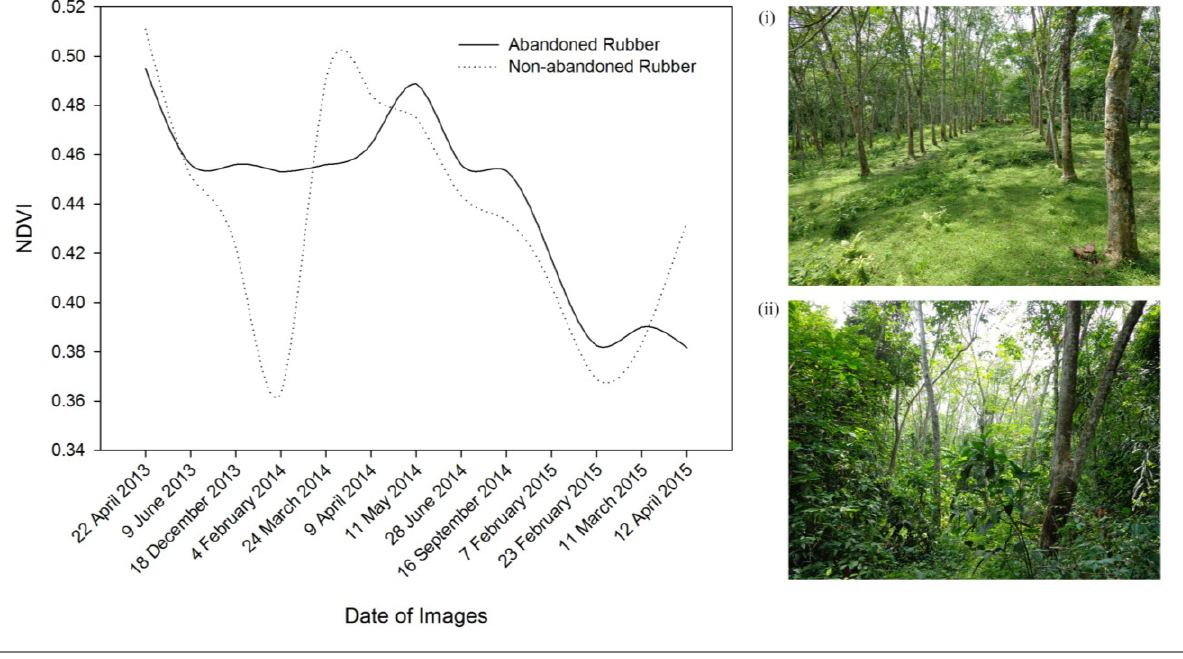
Figure 5. Phenology for rubber; ( i ) non-abandoned rubber; ( ii ) abandoned